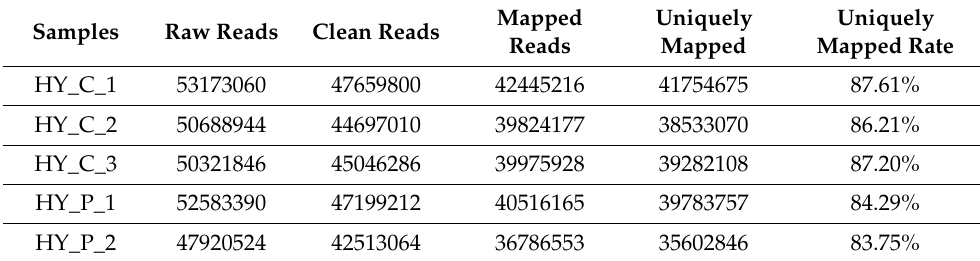
Table 1. Sequencing statistics of the transcriptome samples.